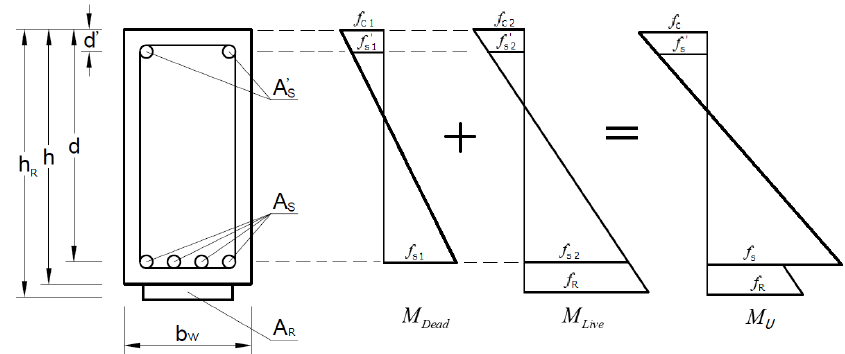
Figure 1. Stress diagram of a strengthened beam. Source: Adapted from Silveira